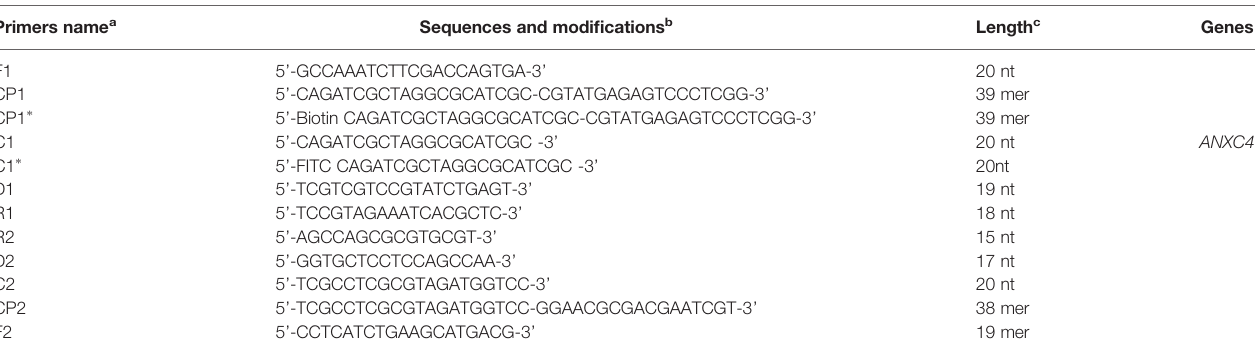
TABLE 2 | The primers used in the current